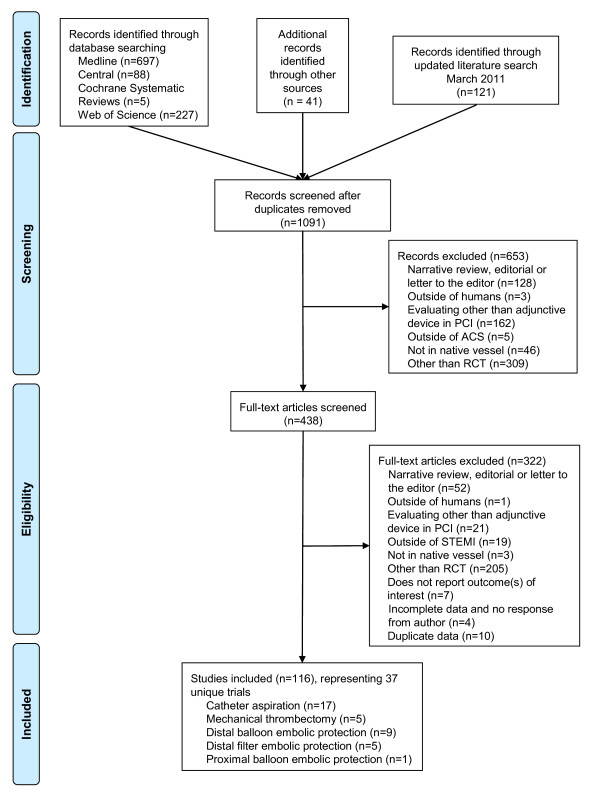
Preferred Reporting Items for Systematic Reviews and Meta-Analyses. Diagram Abbreviations: n = number; PCI = percutaneous coronary intervention; PRISMA = preferred reporting items for systematic reviews and meta-analyses; RCT = randomized controlled trial; STEMI = ST segment elevation myocardial infarction.